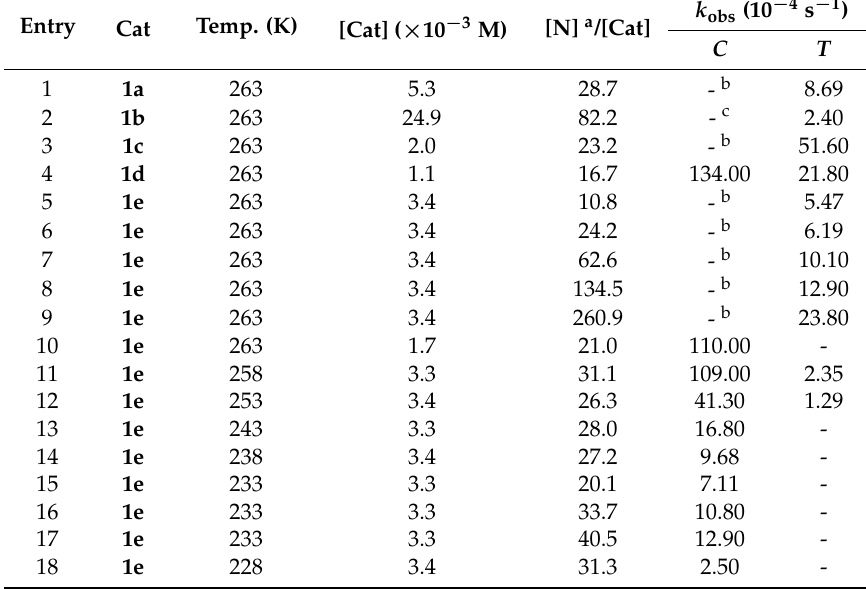
Kinetic data for norbornene insertion reactions of {[RHNCH 2 ( o -C 6 H 4